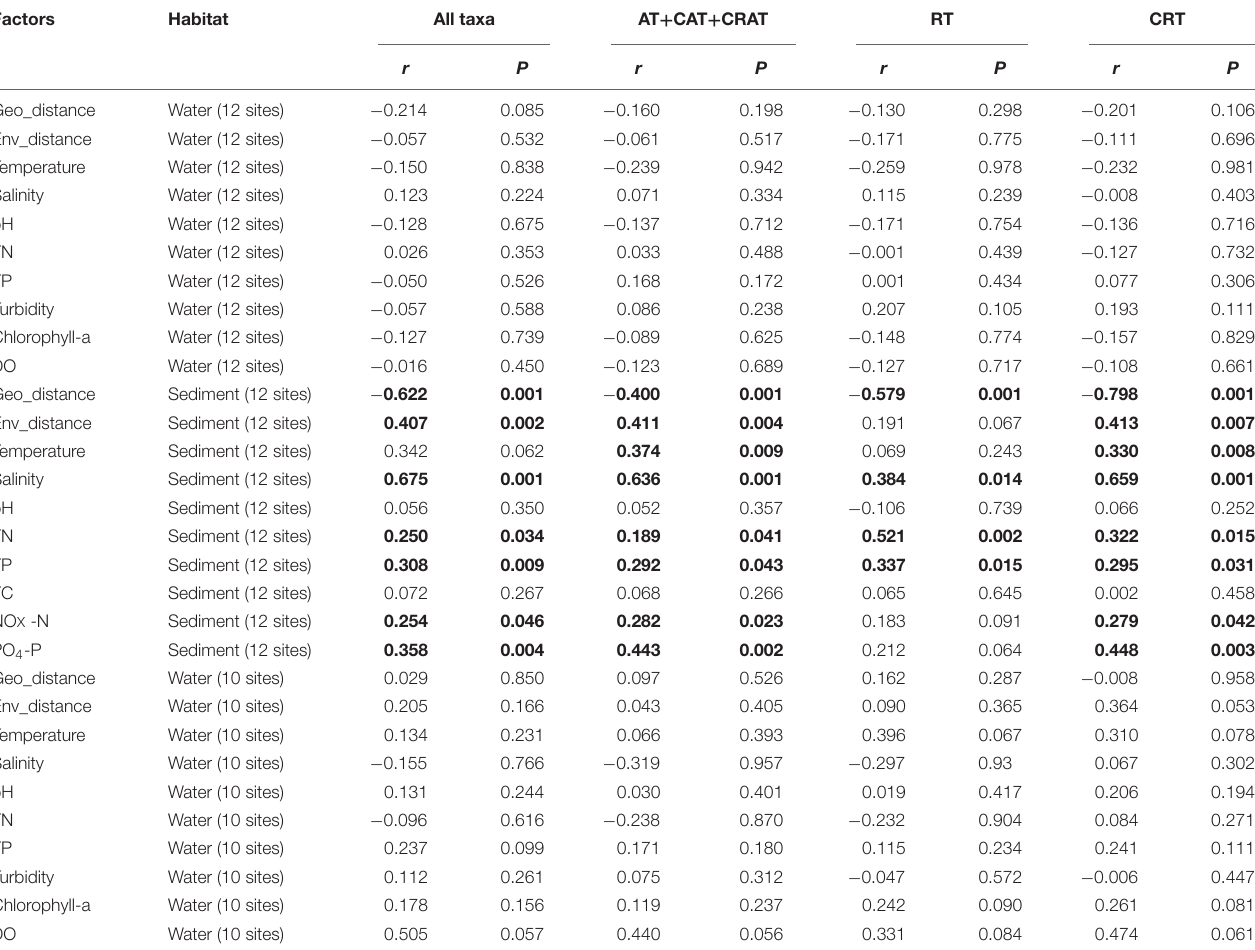
TABLE 1 | Mantel tests for the correlations between geographical distance, environmental distance, individual environmental factors, and microeukaryotic community similarity in water and sediment using Spearman’s coefficients. Factors Habitat All taxa AT + CAT + CRAT